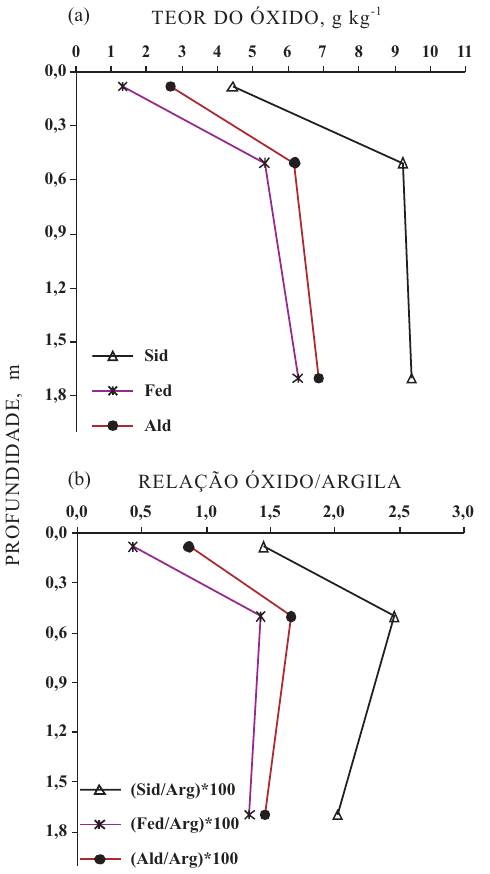
Figura 3. Óxidos de ferro (Fed), silício (Sid) e alumínio (Ald) extraídos por ditionito-citrato- bicarbonato (a) e relações óxidos/argila (b) nos horizontes A (0,0–0,16 m), BA (0,32–0,67 m) e Bw2 (1,37-2,02 m) de um Latossolo Amarelo de São Miguel dos Campos,